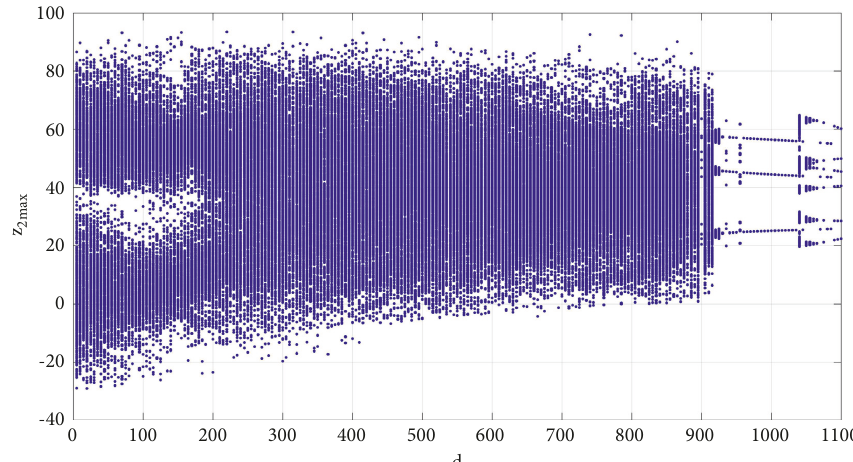
Figure 20: Bifurcation diagram for the model (1) when d varies in [ 0 , 1100 ] and ( a,b, c ) � ( 25 , 8 , 90 ) .